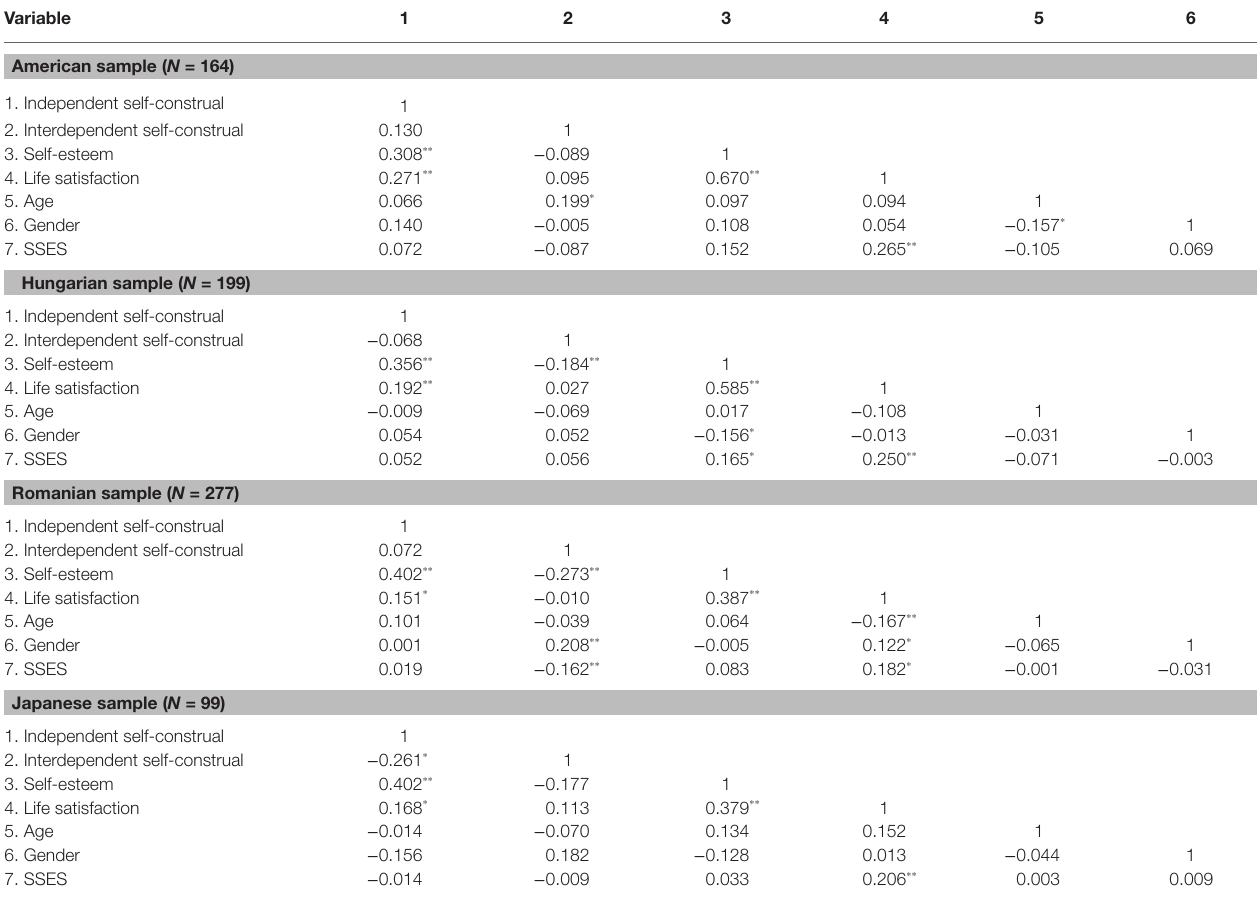
TABLE 3 | Bivariate correlations between all variables in the study in all four cultural samples in Study